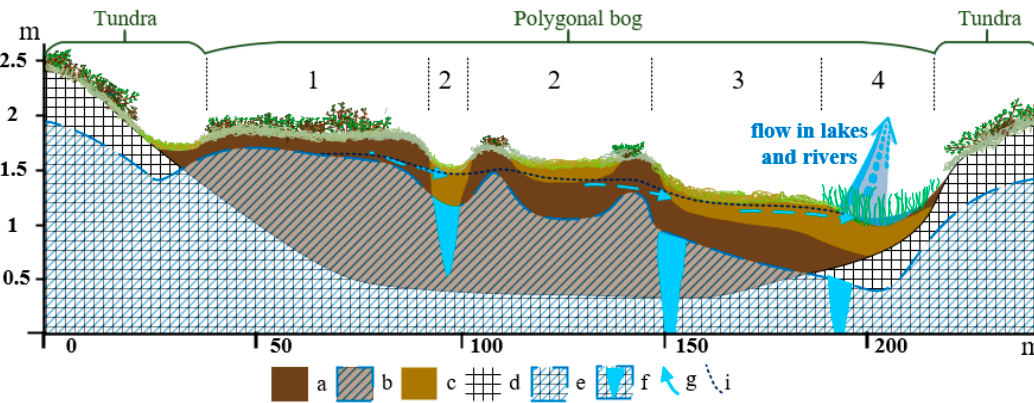
Figure 5. Microtopes of the polygonal bog with a different hydrological regimes of the key site (KS)